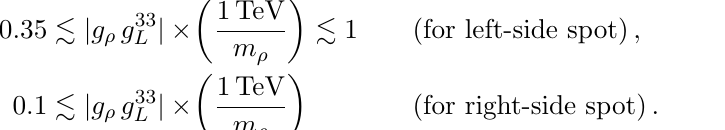
Figure 2 . Allowed regions of the (cid:13)avor constraints for various choice of j g (cid:26) g 33 near (cid:18) D (cid:24) 0. The signi(cid:12)cant constraints from (cid:1) M s (magenta), B ( (cid:28) ! 3 (cid:22) ) (cyan), and the b ! s(cid:22) + (cid:22) (cid:0) global (cid:12)t (blue) are shown whereas the others are simply omitted. The best-(cid:12)t point, (cid:6) 2 (cid:27) , and (cid:6) 3 (cid:27) ranges to explain the b ! s(cid:22) + (cid:22) (cid:0) anomaly are presented with dotted, dashed, and solid curves,